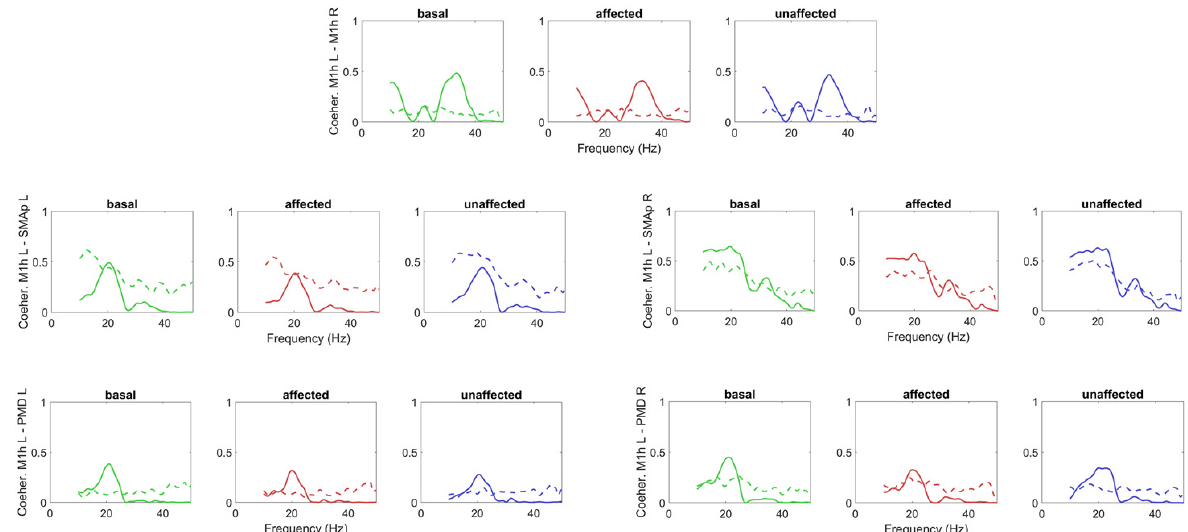
Figure 8. Coherences among the M1h L and all other ROIs obtained in basal conditions (green lines) and during movement of the affected (red lines) and unaffected (blue lines) hands. The continuous lines represent model simulation results with optimal parameter values, and the dashed lines the values computed from the experimental data. It is worth noting that only the coherence M1h L–M1hR in basal conditions was used in the cost function of the fitting procedure. All the others